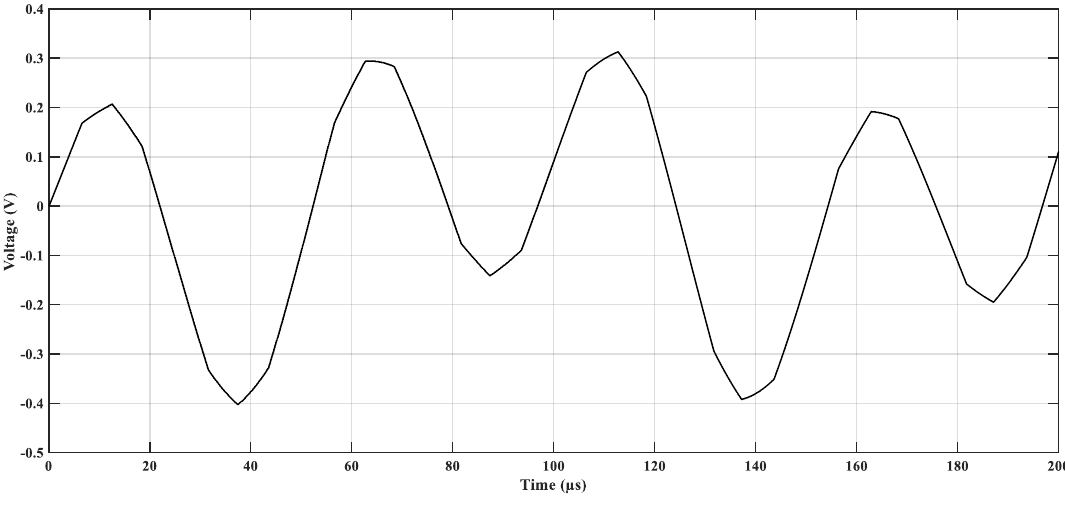
Figure 12. DFIG bearing voltage with the ACMVC.